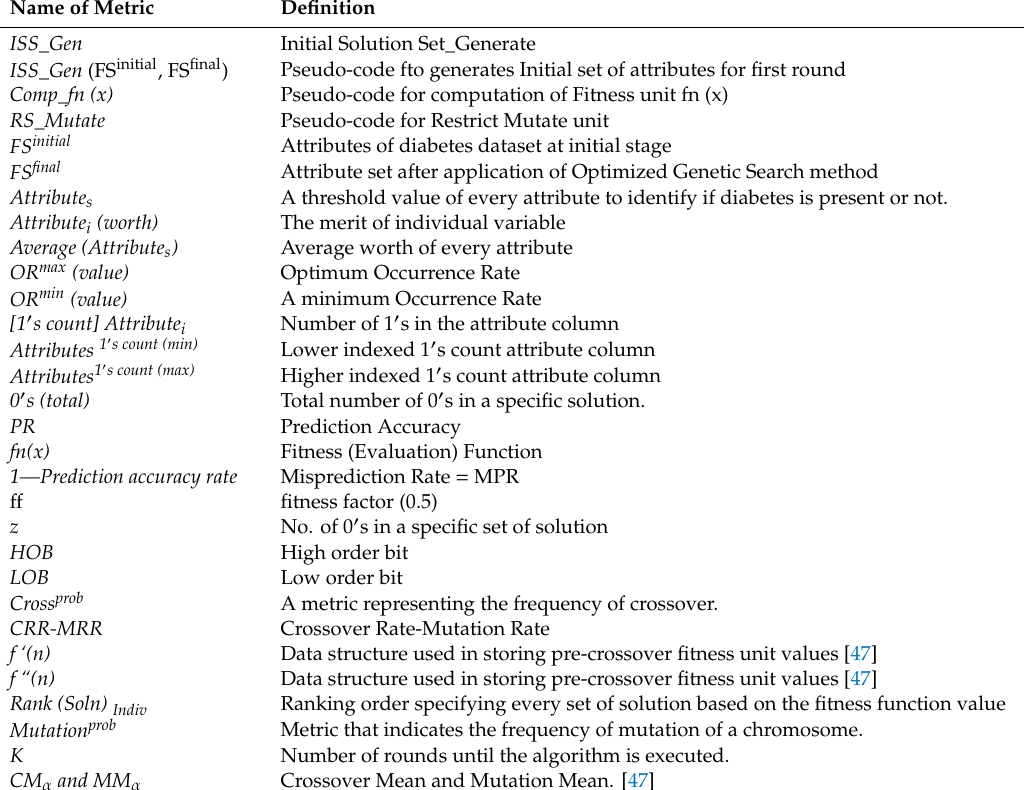
Table 3. Acronyms discussed in the proposed technique